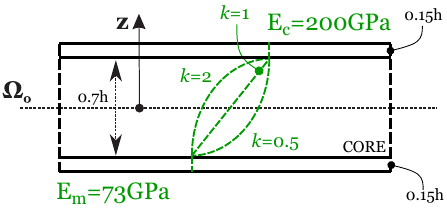
Figure 8. FGM configuration and elastic properties for Cases 3 and